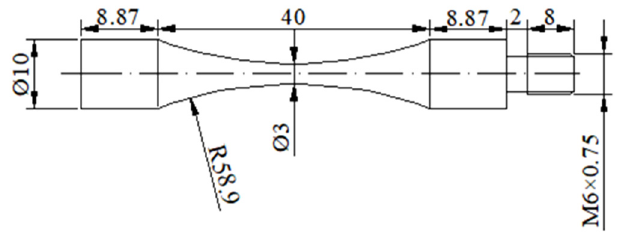
Figure 1. Geometries and dimensions of the test specimens (in mm).